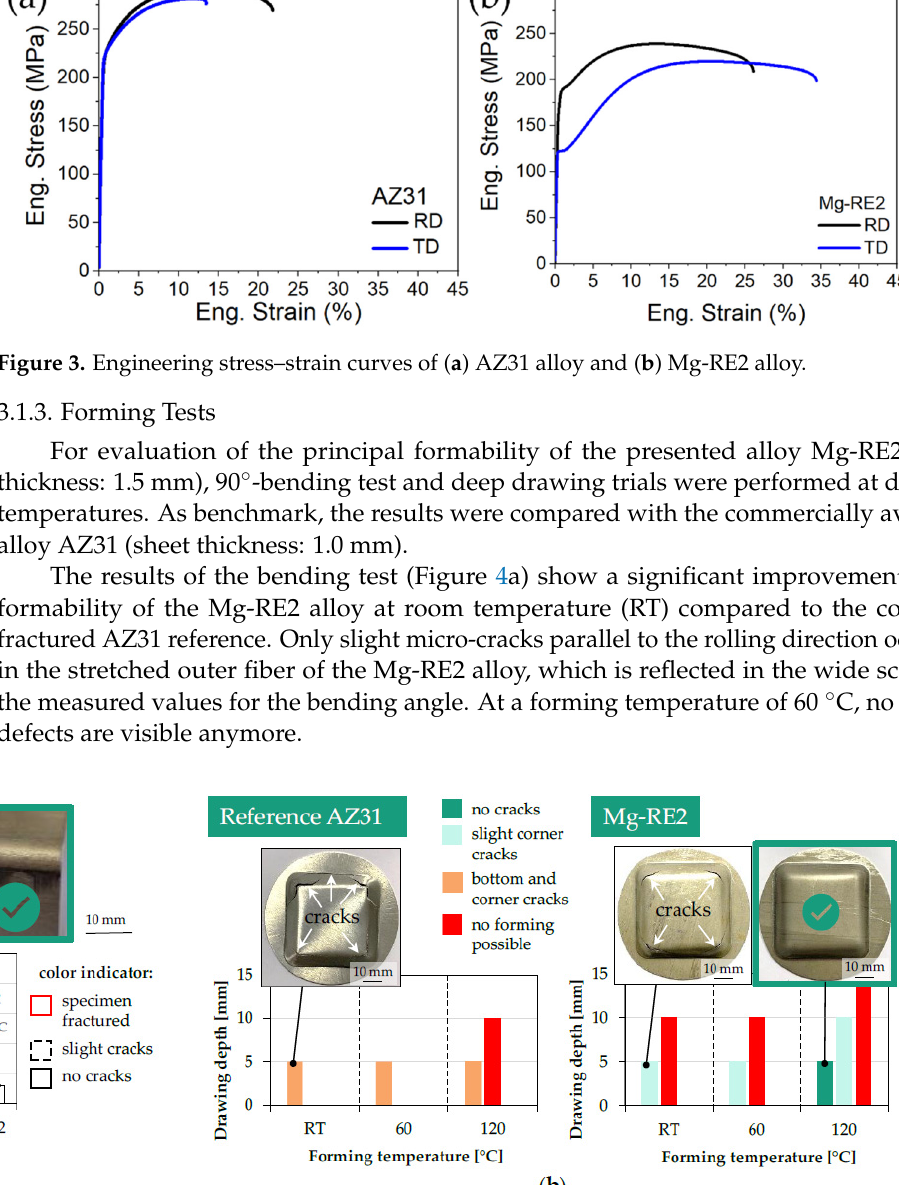
Figure 2. Microstructures and textures in terms of the (0001) pole figure of the: ( a ) AZ31 alloy, ( b ) Mg-RE1 alloy and ( c ) Mg-RE2 alloy.